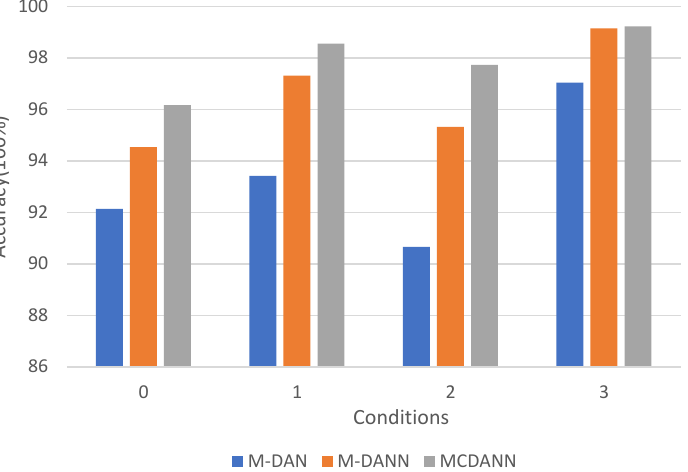
Figure 9. CWRU classification accuracy comparasion of three multi-source domain adaptation models on unknown working conditions without labels (SNR = −